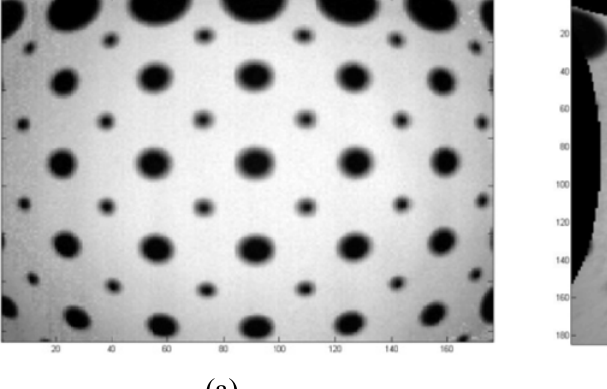
Figure 14. (a) Amplitude image of a test field obtained after averaging thirty frames (b) Amplitude image obtained after averaging thirty frames and after correction from lens